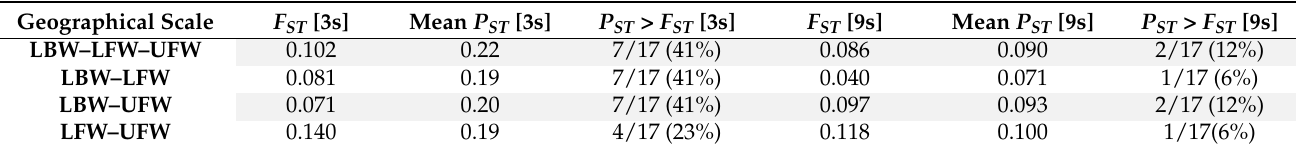
Table 2. Proportion of P ST values that significantly exceed neutral genetic divergence F ST at four geographical scales. Included are the 14 morphological traits (excluding standard length) and relative warp 1 and relative warp 2 defining variation in body shape. LFW: lowland freshwater, LBW: lowland brackish water, and UFW: upland